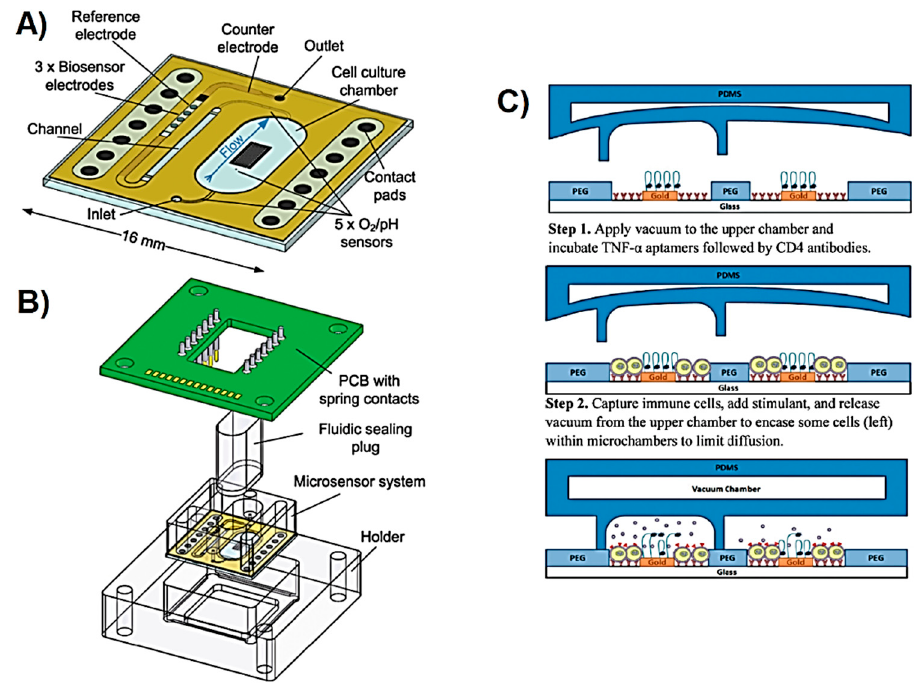
Figure 5. ( A ) The Illustration of the layout of the chip used for growing and monitoring human brain cancer (T98G) cells with primary features noted, ( B ) the system components and electric interface, republished with permission of Royal Society of Chemistry, from [97] (2014) permission conveyed through Copyright Clearance Center, Inc. ( C ) The illustration for the reconfigurable microfluidic device, which is actuated to lower a microcup around a selected group of cells being captured by the antibodies after which the cytokines released are detected with the biosensors, republished with permission of Royal Society of Chemistry, from [88] (2014) permission conveyed through Copyright Clearance Center,